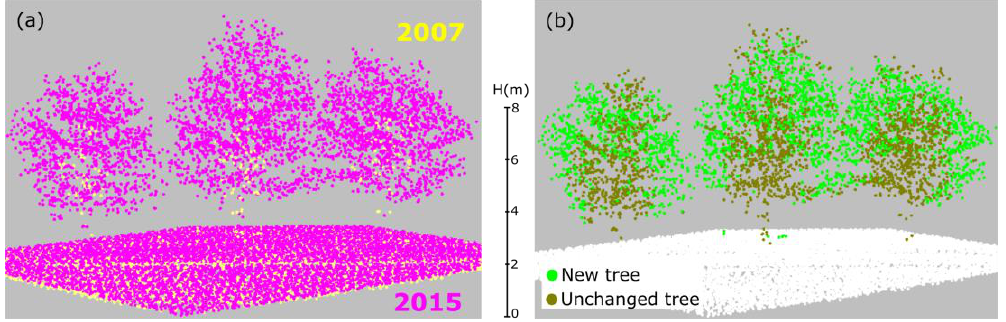
Figure 11. New planted trees at the same location with lost tree: ( a ) point cloud in 2007 and 2015; and ( b ) change detection and classification results).